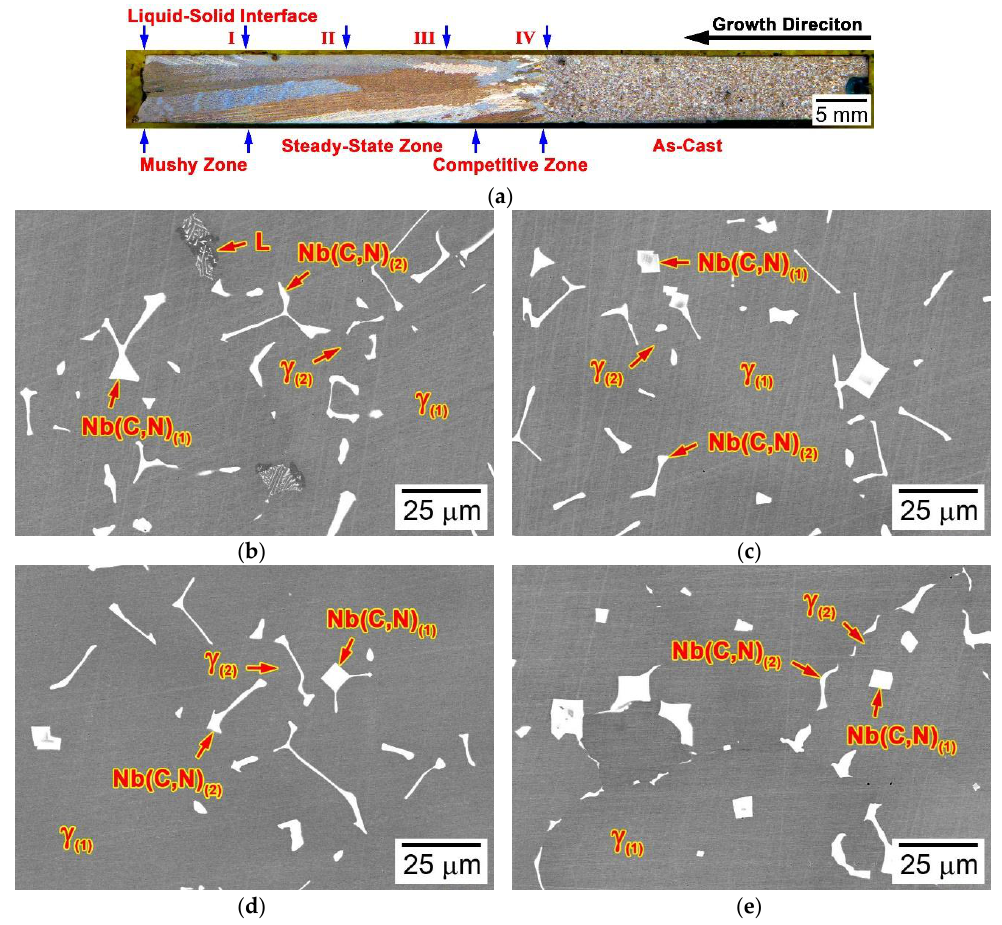
Figure 8. ( a ) Optical image of alloy 2C4N showing the liquid-metal quenched longitudinal macro- grain structure of the DS bar after the LMC-DS processing; SEM-BSE images were taken at distances of ( b ) 10, ( c ) 20, ( d ) 30, and ( e ) 40 mm away from the liquid-solid interface in Figure 8a, showing the microstructural evolution in the steady-state zone and the competitive zone.